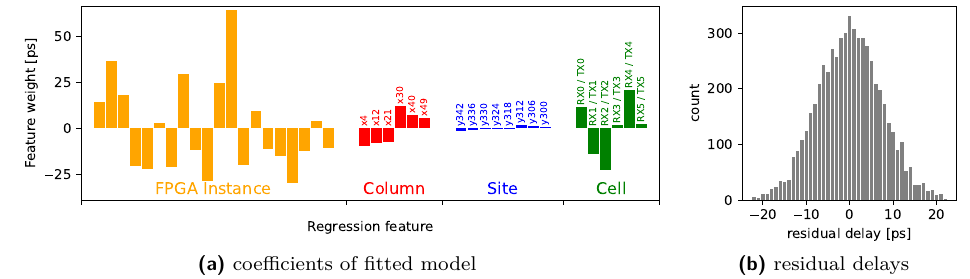
Figure 5: Plot shows regression model coefficients and residual delays. The residual delays show that the model cannot explain all of the variation between the SLL delays. The standard deviation of the residuals is 7.309